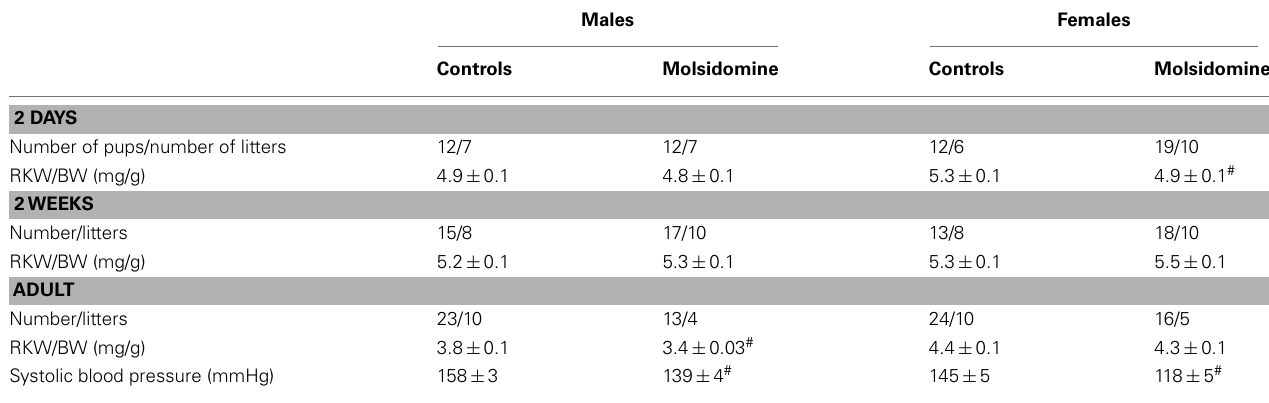
Table 1 | Biometrical data of control FHH and FHH during molsidomine (2days and 2weeks) or after perinatal molsidomine (adult).